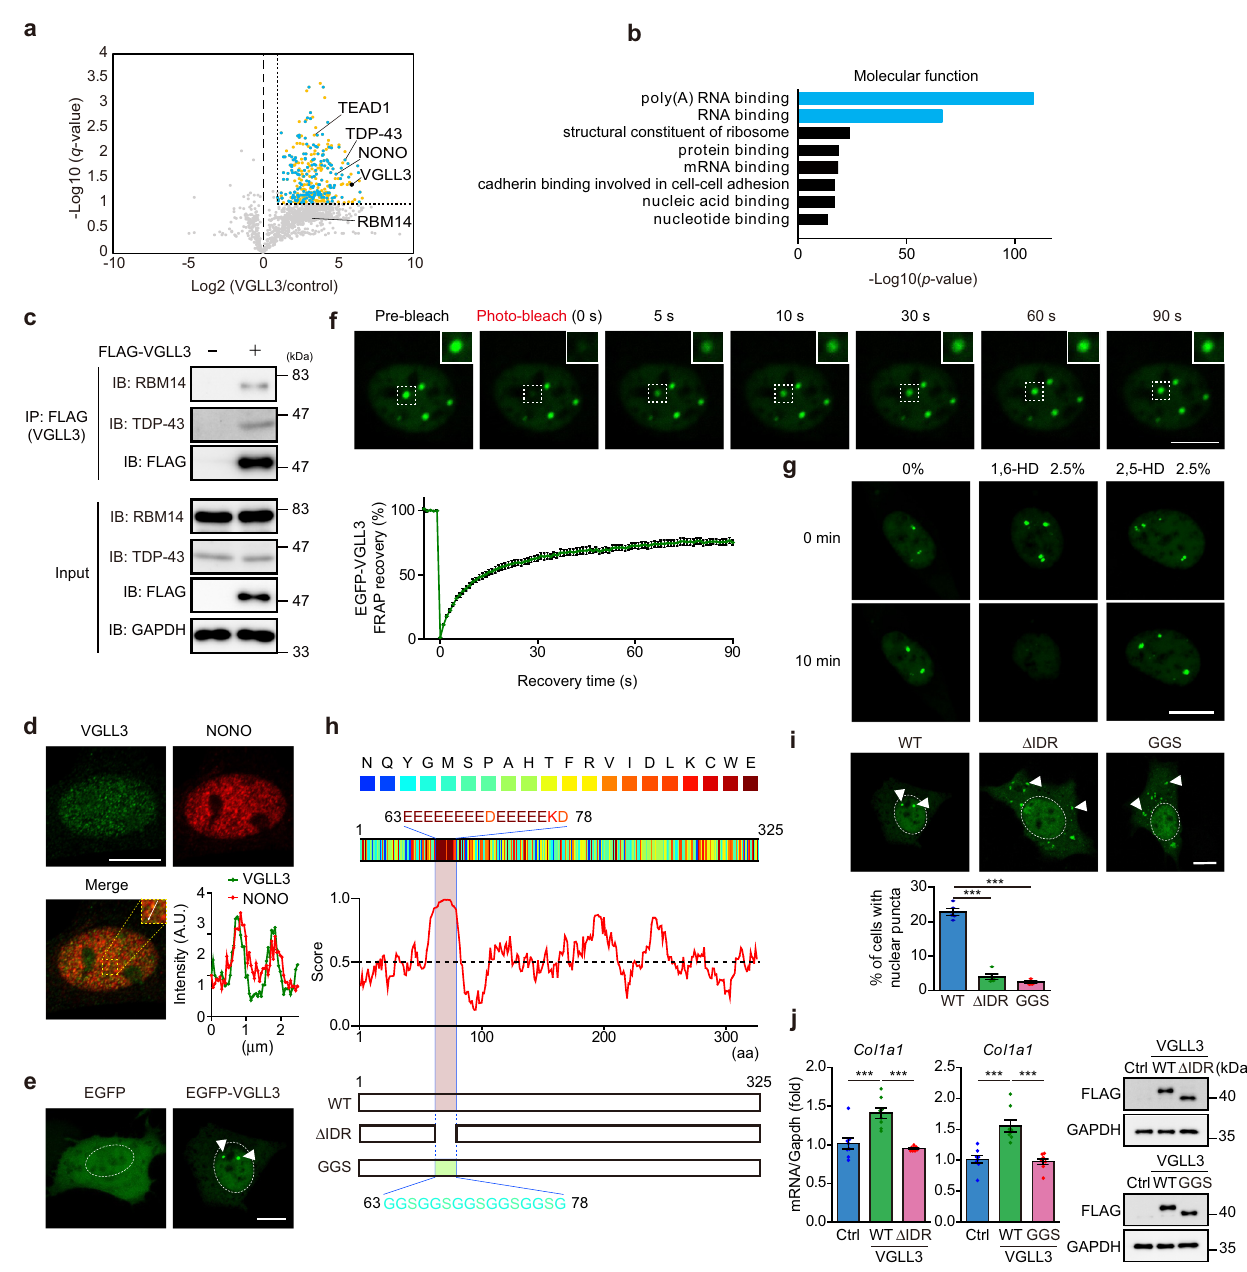
Fig. 4 | VGLL3 undergoes liquid – liquid phase separation through its glutamic acid-richlow-complexitydomain.a Volcanoplotofdifferentialproteinpro fi lesin anti-FLAG immunoprecipitates from control and FLAG-VGLL3 – overexpressing myo fi broblasts. Orange and blue dots represent the proteins ( q <0.1, fold increase >2). Blue dots represent poly-(A) RNA binding and RNA binding proteins. b Enrichment analysis of the ontology for proteins that signi fi cantly interact with FLAG-VGLL3. c InteractionbetweenFLAG-VGLL3andendogenousRBM14andTDP- 43 in cardiac myo fi broblasts. d Immunostaining of endogenous VGLL3 and NONO inmyo fi broblasts.Thegraphrepresentslinescansalongthewhitelineintheyellow dashed square in the inset. e Images of live NIH3T3 cells overexpressing EGFP or EGFP-VGLL3. f Fluorescence recovery after photobleaching (FRAP) analysis of EGFP-VGLL3 puncta in live NIH3T3 cells. The mean intensity of normalised fl uor- escence wasshown in the graph ( n =15). g Effects of1,6-HD and 2,5-HD treatments on EGFP-VGLL3 puncta in NIH3T3 cells. h Scheme of the primary sequence of